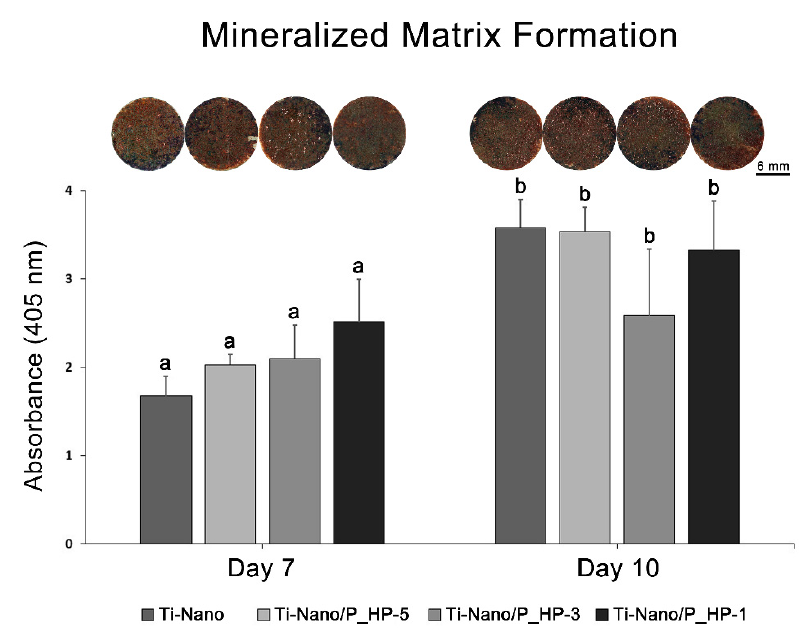
Figure 8. Macroscopic imaging and Alizarin red extraction of UMR-106 cell cultures grown on Ti- Nano functionalized with 1 × 10 − 5 , 1 × 10 − 3 , 1 mg/mL grape-pomace extract and the control surface (Ti-Nano, Ti-Nano/P_HP-5, Ti-Nano/P_HP-3, Ti-Nano/P_HP1) on days 7 and 10 of culture. Cultures were stained with Alizarin red for the detection of calcium deposits in areas of mineralized matrix formation, which were randomly distributed throughout the entire disk surface (scale bar = 6 mm). The 1 mg/mL group showed a tendency toward greater calcium content on day 7 of culture. Bars that share the same letter are not significantly different from each other ( p > 0.05). A comparison between periods was not performed.